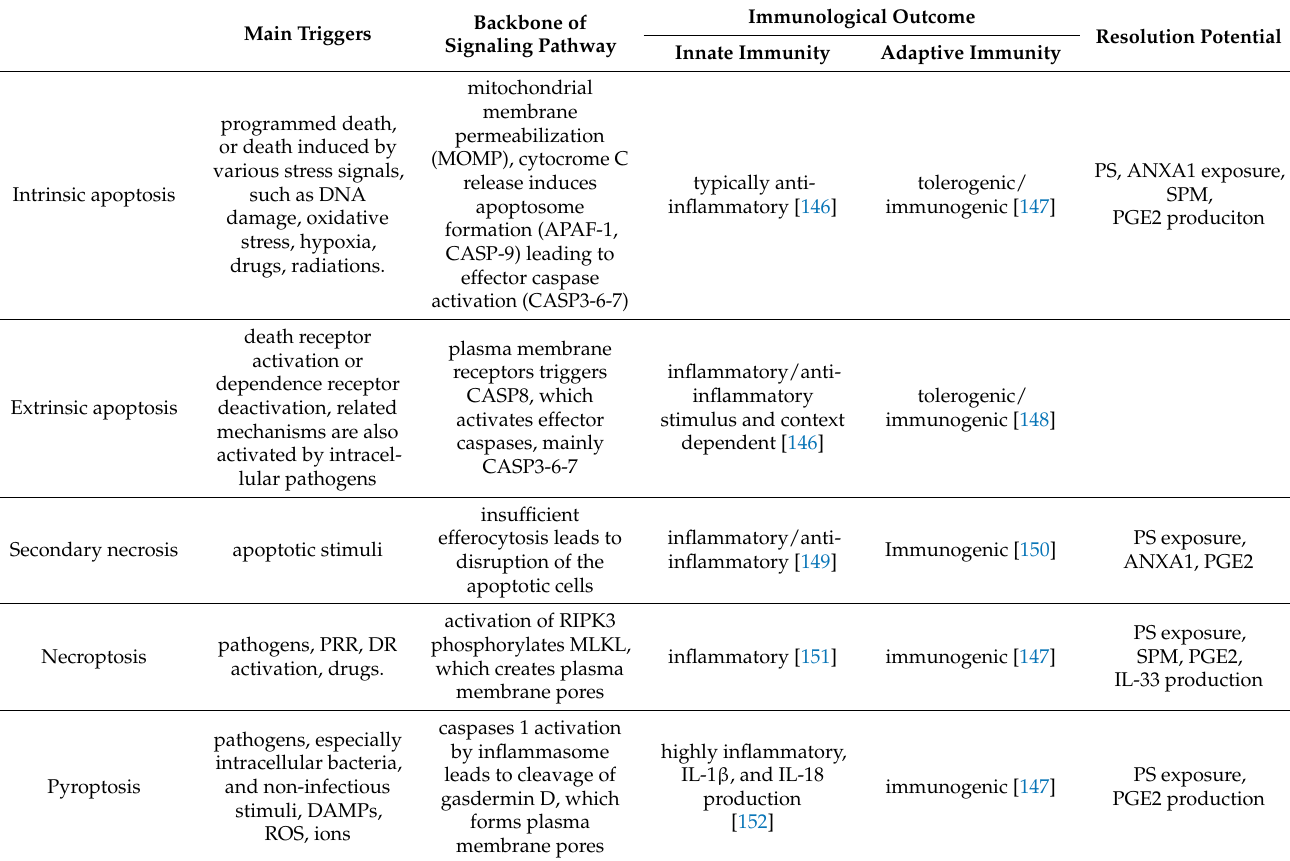
Table 3. Brief summary of cell death pathways. We refer to [5] for deeper